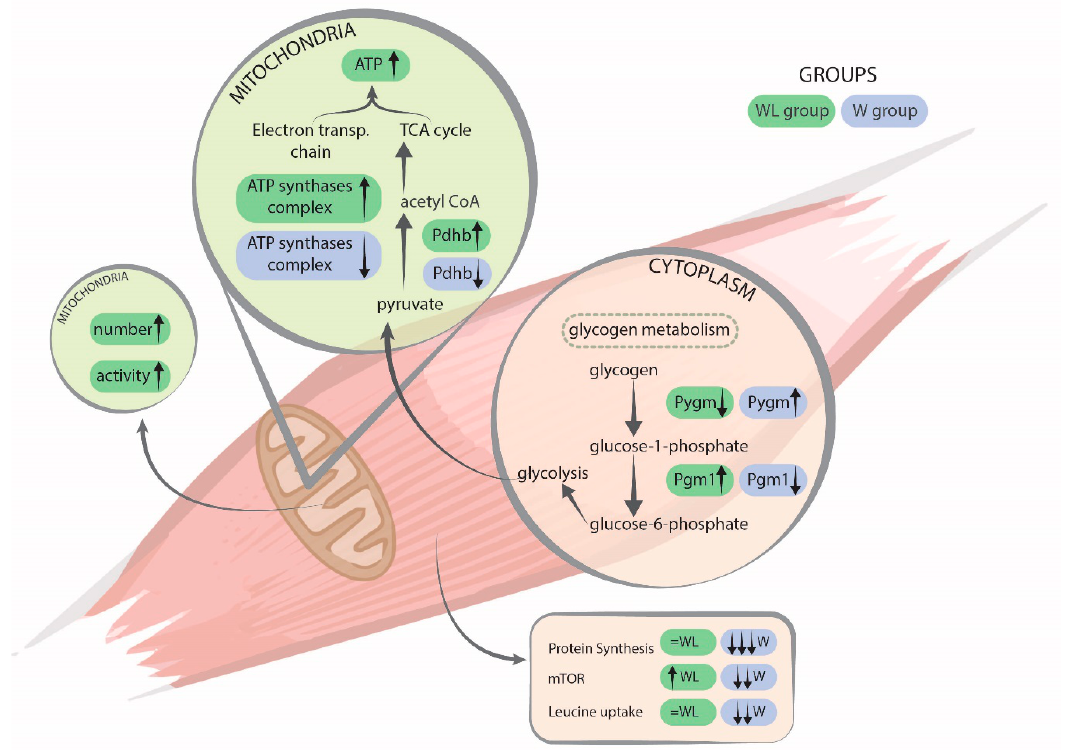
Figure 7. Illustration summarising the main processes found in both experimental groups. Legend: W, Walker tumour-bearing group, represented in blue; and WL, tumour-bearing rats fed a leucine-rich diet, represented in green colour. Arrows directions show the variation of the events between both groups. Glycogen phosphorylase (Pygm) is involved in muscle glycogenolysis and glycolysis. Phosphoglucomutase-1 (Pgm1) has a catalytic activity breakdown and synthesis of glucose. Pyruvate dehydrogenase E1 component (Pdhb) plays a role in the process of converting pyruvate to Acetyl-CoA. ATP synthases complex is for the production of ATP by the respiratory chain, mitochondrial function. Muscle protein synthesis and signalling events were published previously by Cruz and colleagues [51].